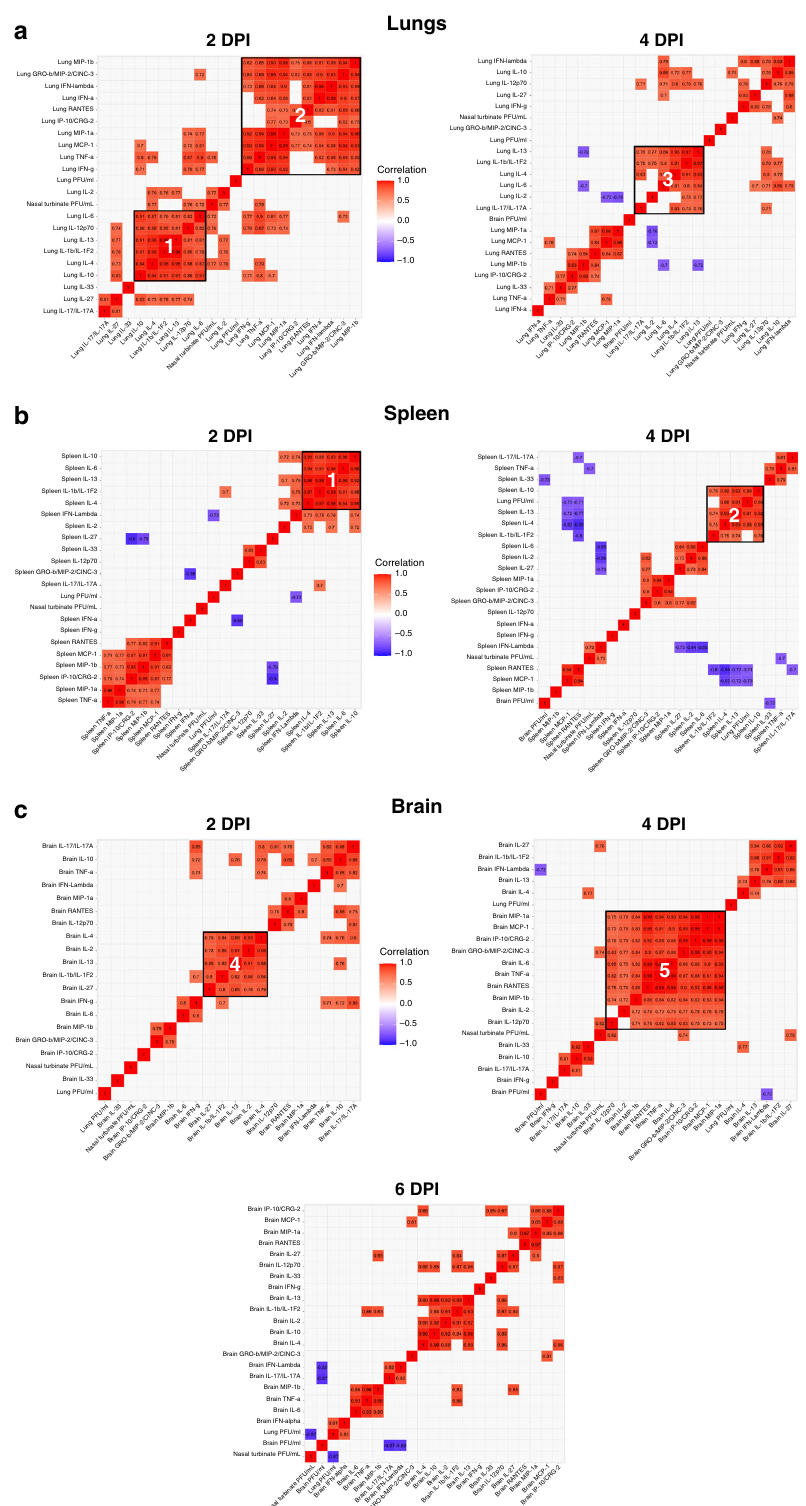
Fig. 4 SARS-CoV-2-infected K18 hACE2 transgenic mice reveal differentiated clusters of chemokine and cytokine correlations with clinical symptoms progression. Hierarchically clustered Pearson correlations of measurements in a lung, b spleen, and c brain of SARS-CoV-2-infected K18 hACE2 transgenic mice. Positive correlation (Red = 1) and negative correlations (Blue = − 1), with clusters (Black outlined boxes with cluster number). Non-signi fi cant values ( p > 0.05 measured by Pearson ’ s correlation t test) were left blank; n = 8 mice (50:50 male:female per time-point studied, except mock n = 2 mice). DPI days post infection. MIP-2/CXCL2; MCP-1/CCL2; MIP-1 α /CCL3; MIP-1 β /CCL4; RANTES/CCL5; IP-10/CXCL10. Data are representative over two independent experiments. Source data are provided as a Source Data fi